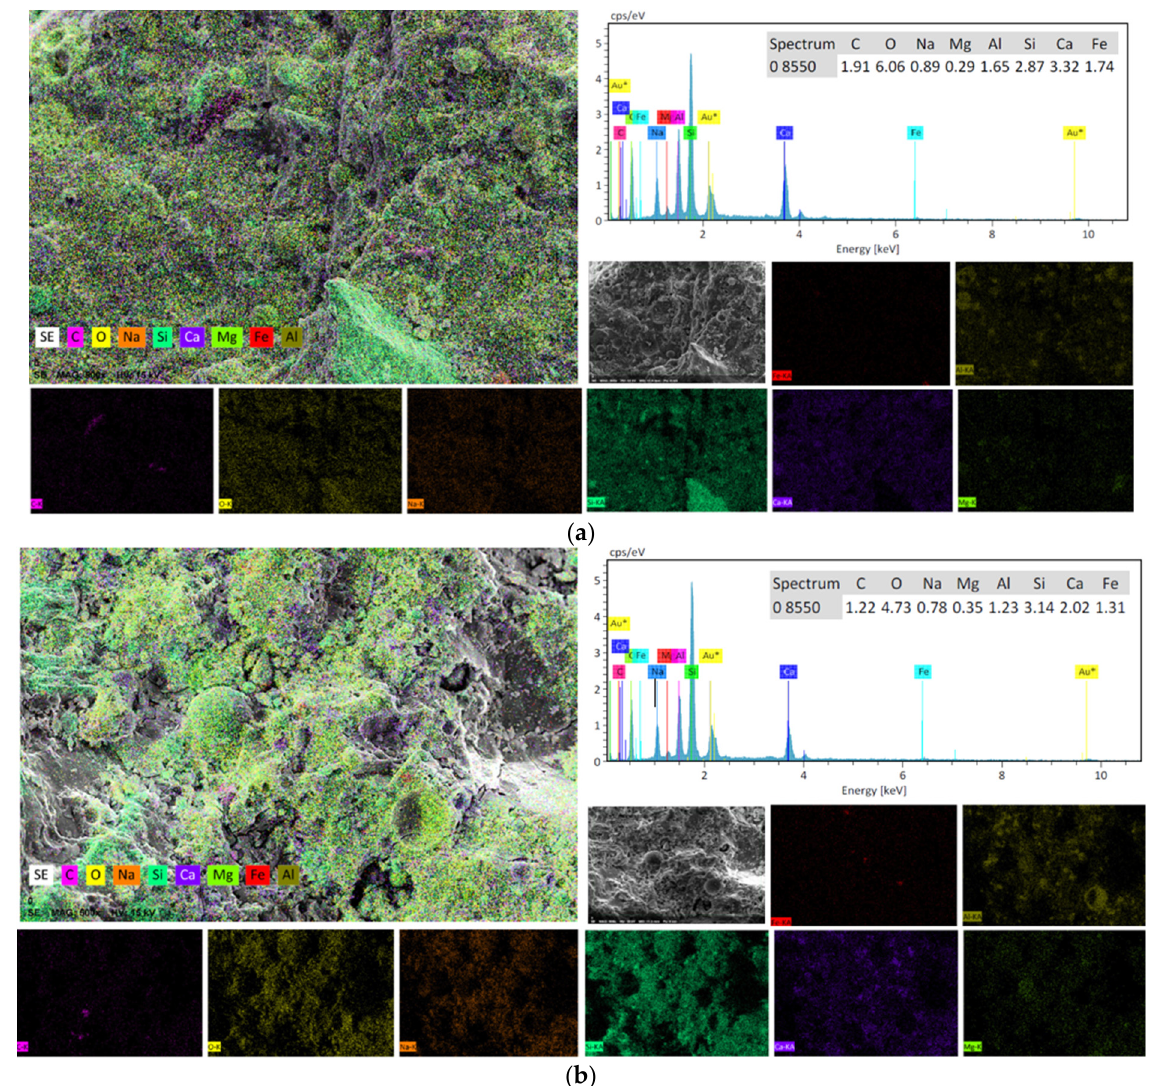
Figure 12. EDX images of AAM containing ( a ) 5% and ( b ) 15% BGWNP.